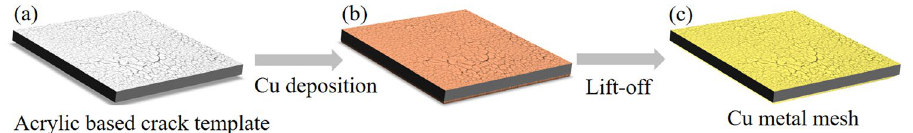
Figure 1. Schematic illustration for preparing copper network films. ( a ) acrylic based crack template; ( b ) deposition of copper on a crack template; ( c ) lift-off the